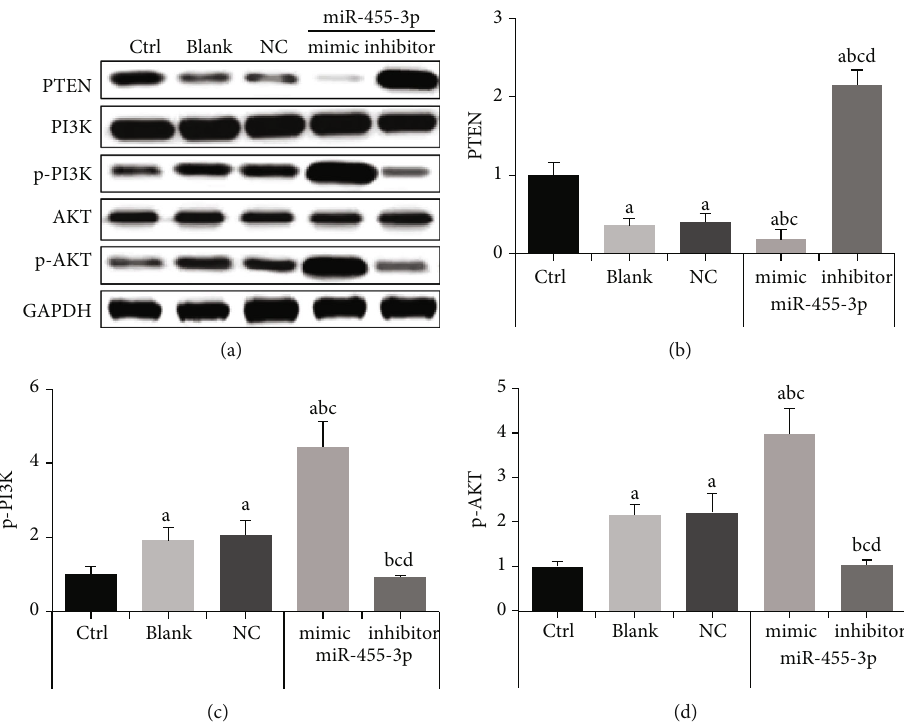
Figure 7: Detections of PTEN, PI3K, and AKT in BMSCs. (a) Western blot graph. (b) Expression of PTEN. (c) Phosphorylation level of p- PI3K. (d) Phosphorylation level of p-AKT. Note: A, B, C, and D meant P < 0 : 05 in comparison to the Ctrl, blank, NC, and mimic groups, respectively.